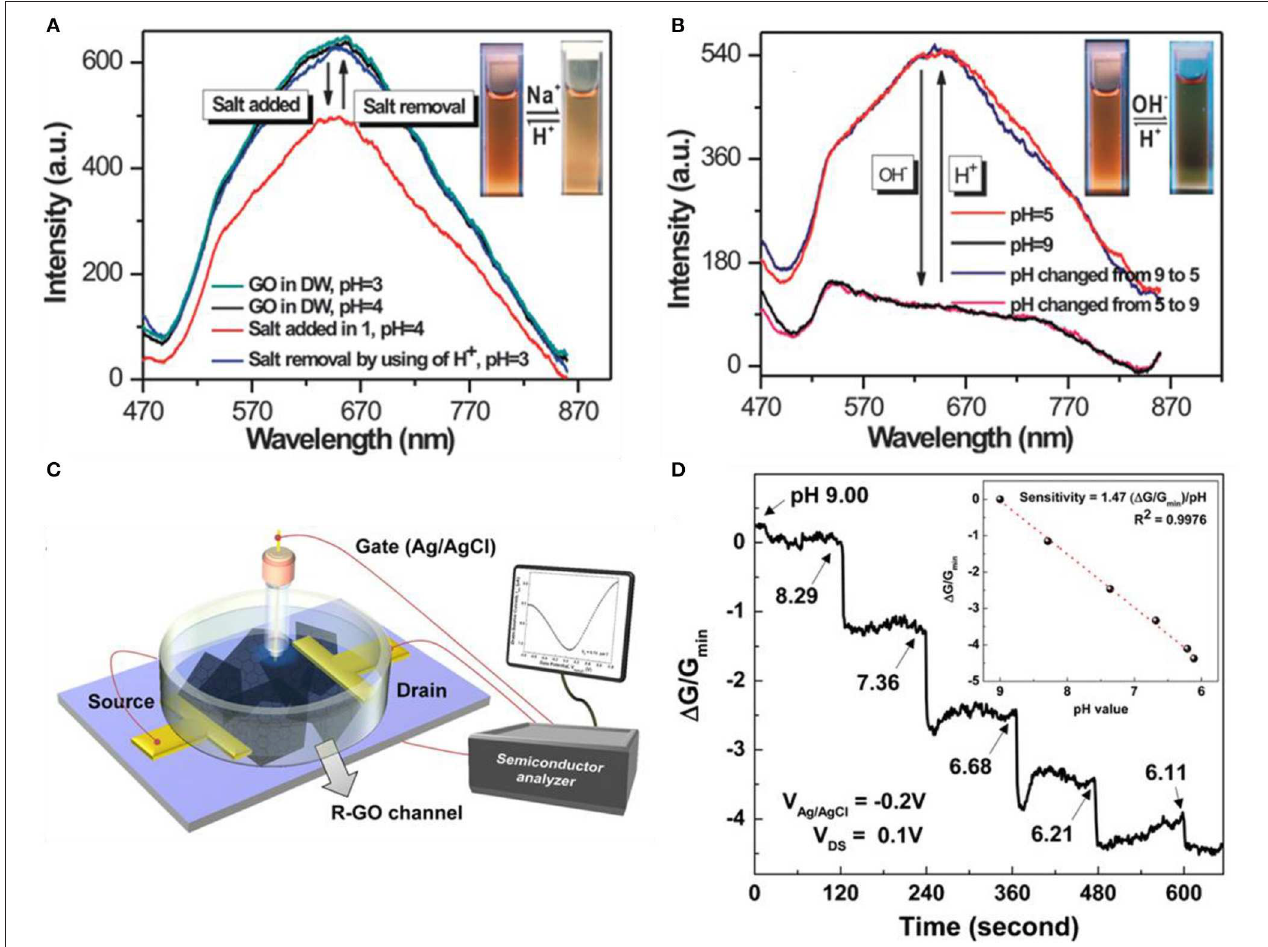
FIGURE 3 | Graphene oxide (GO)- and reduced graphene oxide (RGO)-based pH sensors. (A) Reversible vis-NIR fluorescence change of acidic vs. salt states. (B) Reversible vis-NIR fluorescence change of pH. Figures (A,B) were reproduced from Chen and Yan (2011) with permission from the Royal Society of Chemistry. (C) Schematic diagram of an RGO field effect transistor. (D) Typical sensing curves along pH alter RGO. Figures (C,D) were reproduced from Sohn et al. (2013) with permission from